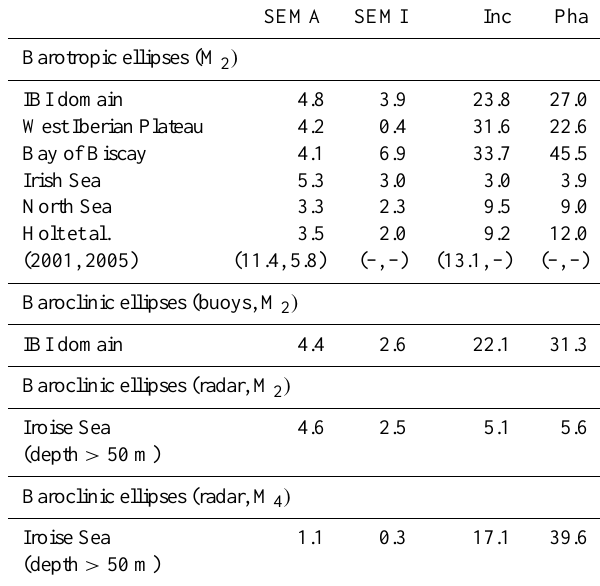
Table 1. RMS error of the complex amplitude difference between observed and modelled tidal components for the sea surface ele- vation. Units are in cm. The studies of Holt et al. (2001, 2005) cover the 48 ◦ N–63 ◦ N, 12 ◦ W–13 ◦ E region and the 48 ◦ N–62 ◦ N, 12 ◦ W–13 ◦ E region, respectively, and results obtained in the stud- ies of Holt et al. (2001, 2005) are presented for comparisons (values in brackets). The Gulf of Cadiz and West Iberian region is delimited